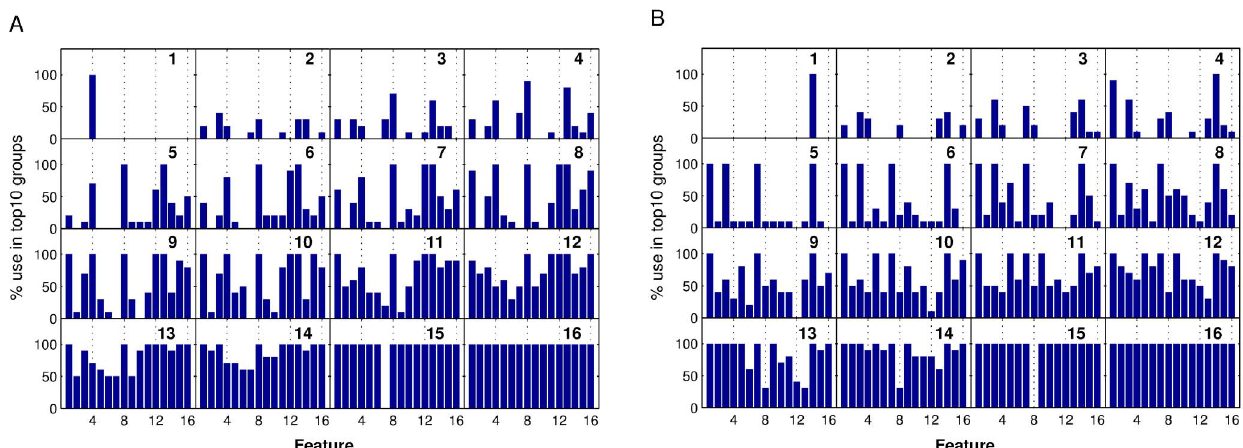
Figure 7. Distributions of the occurrence of individual features in the top10 feature groups for each given size of the feature set from 1 (top left panel) to 16 (bottom right panel) features. If a single feature is used, feature 4 (CV of spike width) is best for data set 1 (A) and feature 14 (minimum spike slope) for data set 2 (B), but when using 2 or more features, combinations involving other features work best. The highly successful feature sets between 5 to 10 features (second row) show some commonalities in that for data set 1 (A) features 8 (std of noise level) and 13 (maximum spike slope) are always included and for data set 2 (B) features 1 (mean spike height), 3 (CV of spike height), 8 (std of noise level) and 14 (minimum spike slope) play a dominant role. It is noteworthy that observations reported here do not seem to generalize well between the two data sets used in this study.